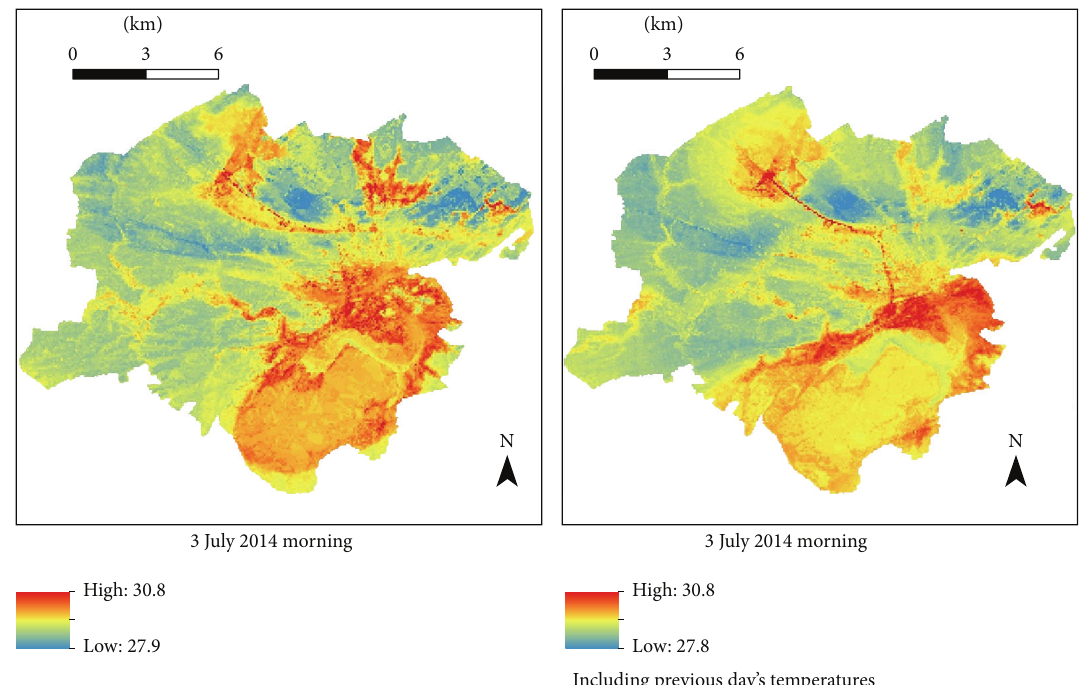
Figure 14: Estimated temperatures ( ∘ C) for 3 July 2014 morning. Left image does not include lag-1 variable and right image includes lag-1 variable.